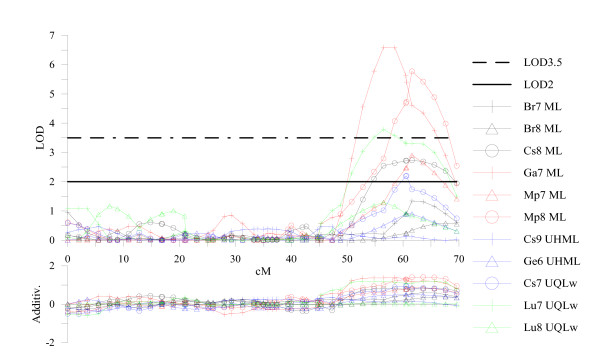
Variation of the LOD score profiles along chromosome 4 for fiber length measurements. Graphical representation of the variation among 11 data sets of the LOD score profiles (upper panel) and of the observed additivity effect (in mm) as conferred by the Gh parent (lower panel) along chromosome 4 for fiber length measurements (either HVI-based, as Upper Half Mean Length, UHML or Mean Length, ML, or AFIS-based, as Upper Quartile Length per weight, UQLw). Phenotypic data were obtained from 11 experiments of the RIL population and analyzed with WinQTL Cartographer by composite interval mapping (loci positioned on the RIL map). The 2 horizontal lines correspond to 2 different LOD thresholds: the permutation-based (1000 permutations) threshold averaged from the 11 sets, ie LOD = 3.5 (dotted line), and an arbitrary value of LOD = 2 (solid line).